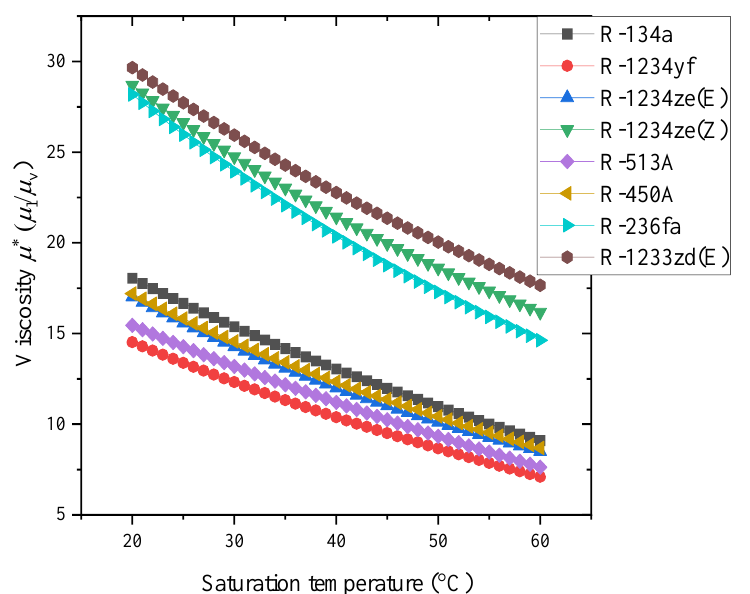
Figure 23. Saturation temperature versus liquid to vapor thermal conductivity ratio of alternatives to R-134a [1].